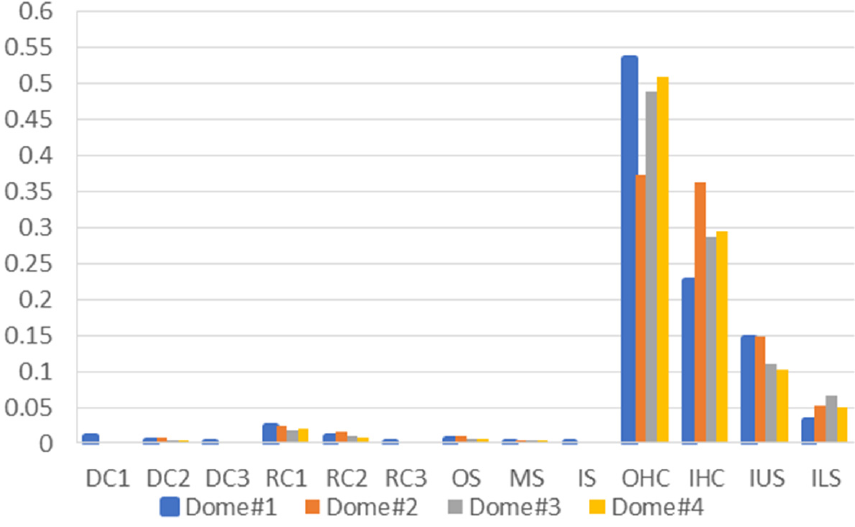
Figure 12. Variations in the importance coefficients of the Cable-Strut elements under different topological relationships for a dome structure .